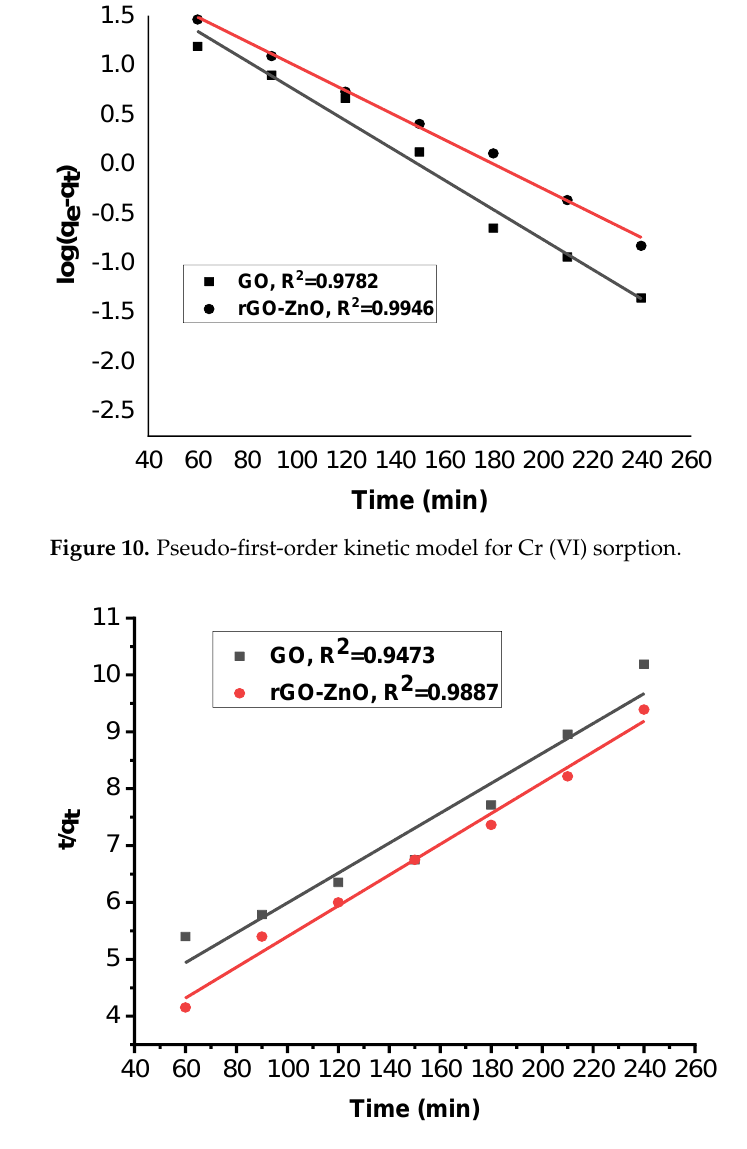
Figure 11. Pseudo-second-order kinetic model for Cr (VI) sorption.